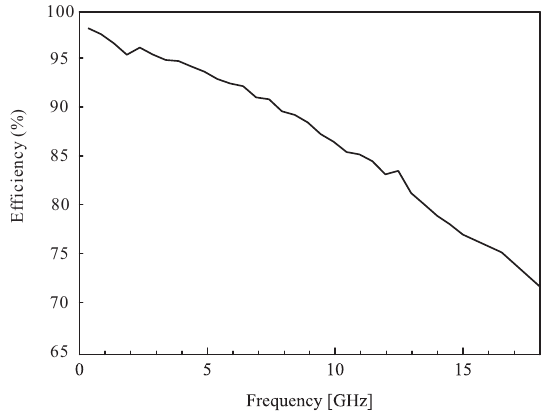
Figure 11. Simulated radiation efficiency of the proposed